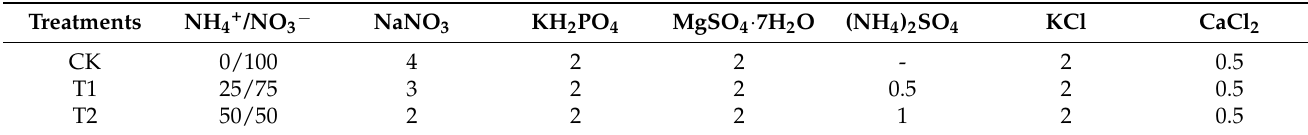
Table 1. Nutrient solution with different NH 4+ /NO 3 − ratios (unit: